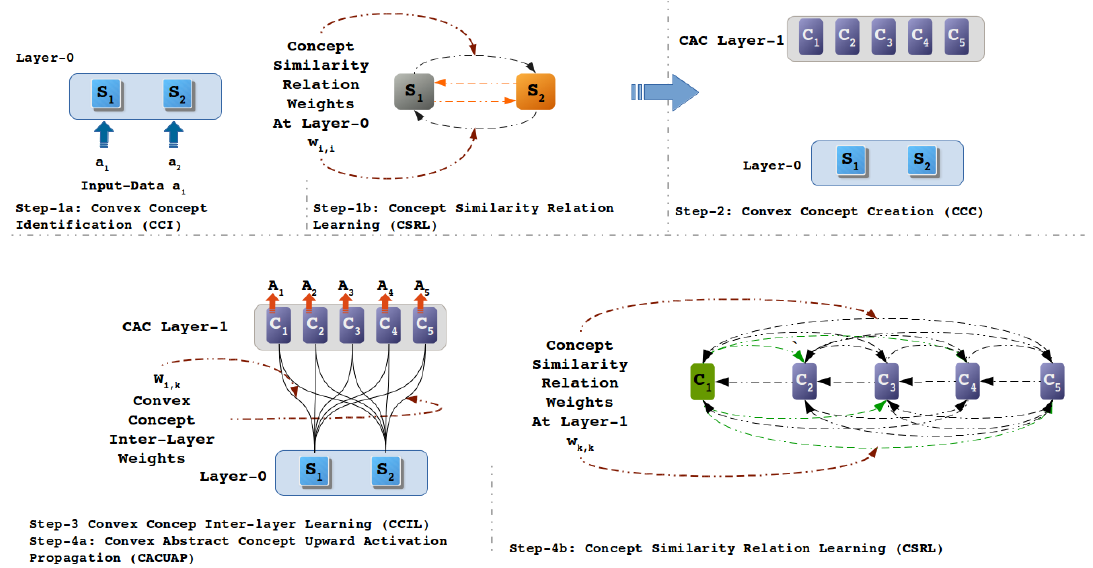
Figure 4. Regulated activation network (RAN) convex abstract concept modeling process. The procedure displays the four steps in RAN modeling. This figure shows the three learning procedures, i.e., two similarity relation learning procedures at two layers, and one inter-layer learning procedure between layer 1 and layer 0. In step 1, similarity relation learning (step 1a) is performed along with the concept identification process (step 1b). Similarly, in step 4, similarity relation learning (step 4b) is performed together with the upward activation propagation method (step